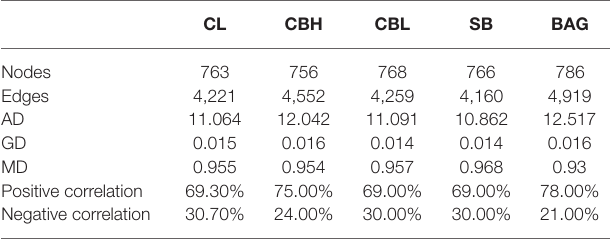
TABLE 9 | Topological properties of co-occurrence network.